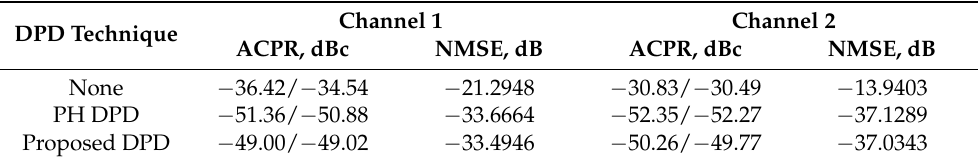
Table 3. DPD results for different models in 2 × 1 MIMO transmitters for LTE 20MHz signal in case 3 ( K = 5 M =